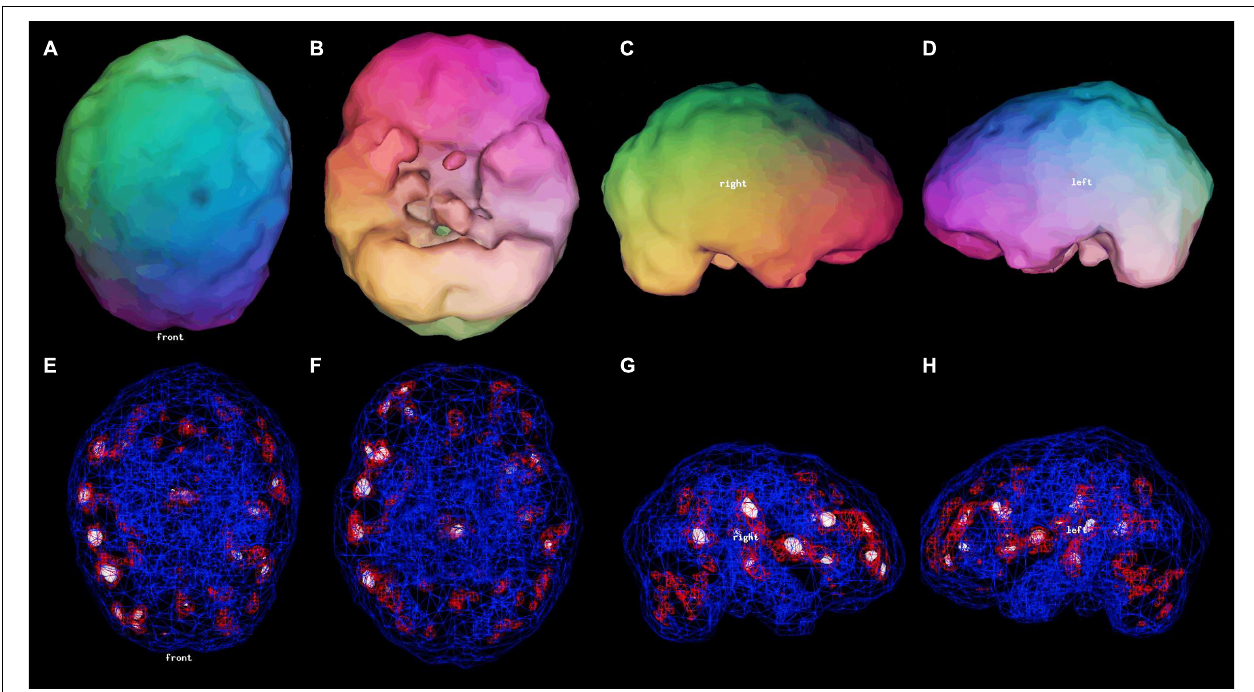
FIGURE 15 | The second SPECT scan of Patient C shown as it was originally viewed after processing with the Picker Odyssey software. (A–D) 3-D representation of the scan data is shown. The surface is set at 60% of brain maximum. Areas which fall below 55% are represented as indentations or holes depending on how far below 55% the activity falls. (A) Vertex view, (B) Underside view, (C) Right Lateral, (D) Left Lateral. (E–H) A wireframe brain representation is shown, wherein the areas of brain with activity at 85% of maximum or greater are shown in red and areas of 92% or greater are shown in white. (E) Vertex view, (F) Underside view, (G) Right Lateral, (H) Left Lateral. The details of the SPECT scan are much harder to appreciate without the tomograms. The extent of the diffuse cortical increased perfusion is much more difficult to appreciate with this post-processing software. The extent of the co-existing areas of hypoperfusion in the parietal cortices are not evident with this post-processing